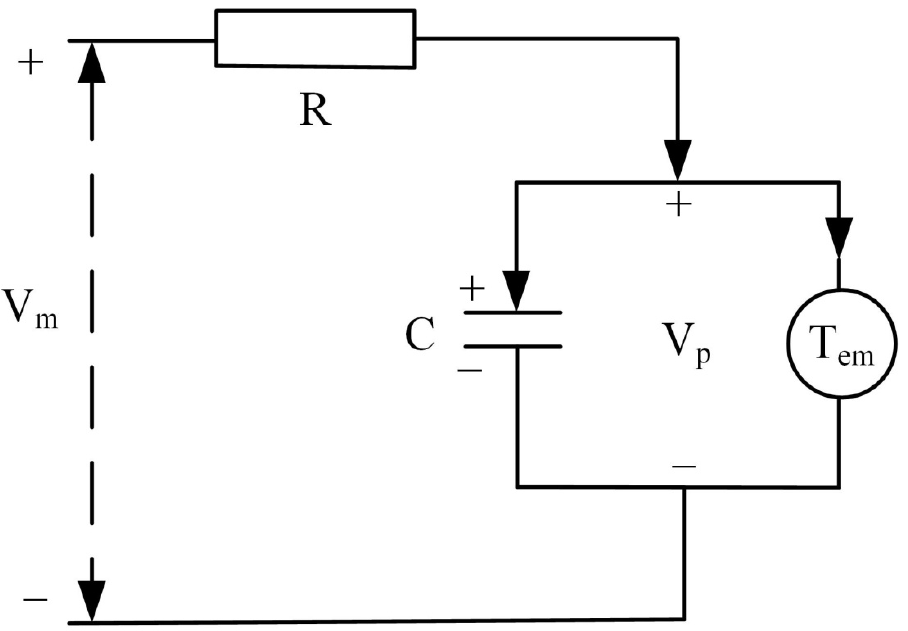
Figure 6. Equivalent circuit of the piezoelectric stack.